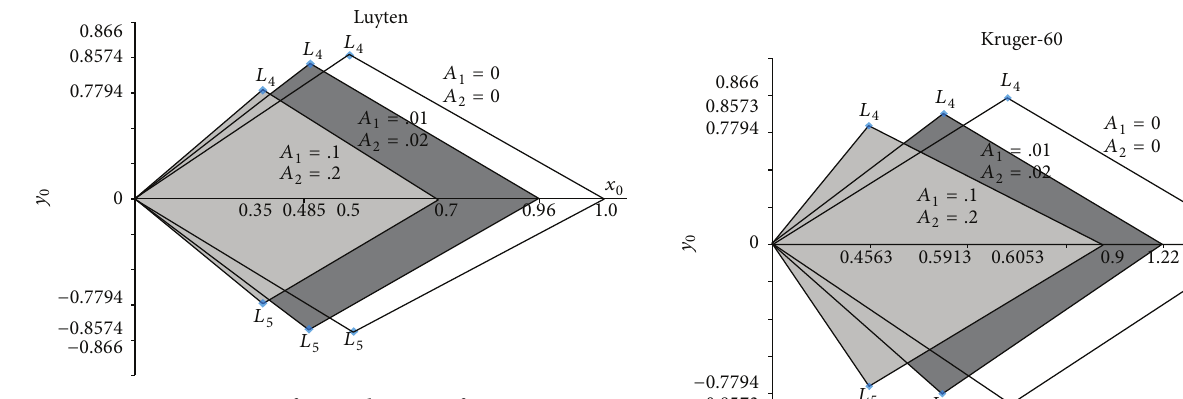
Figure 2: Location of triangular points for Luyten.